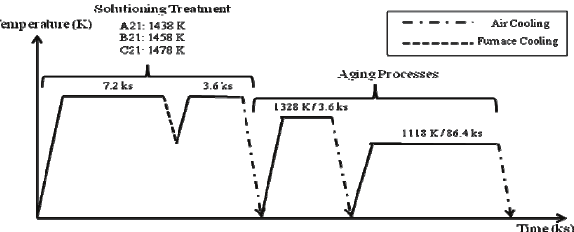
Figure 3. Simulated reheat treatment programs: A21, B21 and C21.